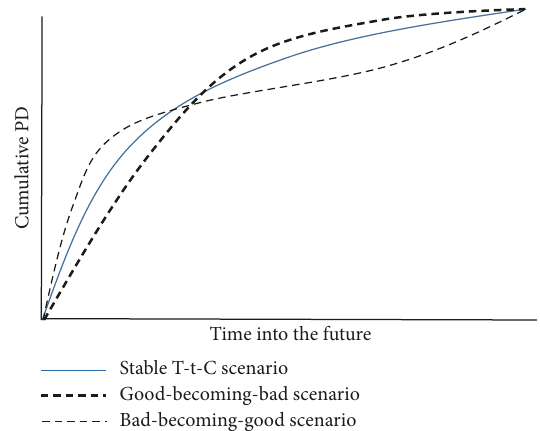
Figure 3: Schematic projections of a scenario-dependent PD term